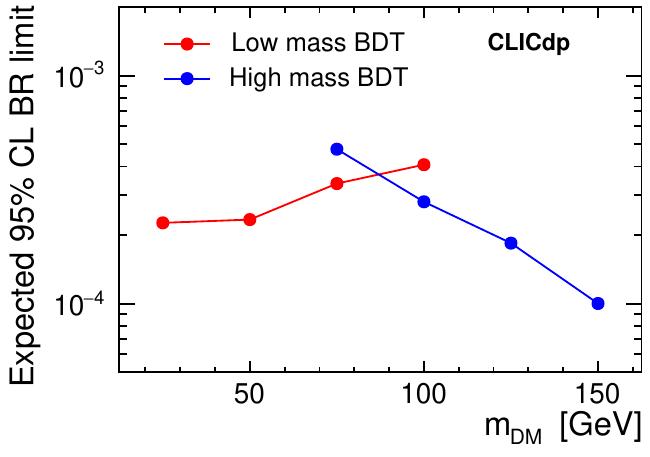
Figure 32. Limits at 95% C.L. on the top quark FCNC decay t ! cE = expected for 1.0 ab (cid:0) 1 collected at 380 GeV CLIC equal amounts of -80% and +80% electron beam polarisation, as a function of the assumed mass of the invisible decay product, m . Limits are calculated from the DM BDT response distribution in the (cid:6) 30 GeV window in the reconstructed particle mass. Two BDT algorithms are trained separately for low and high mass